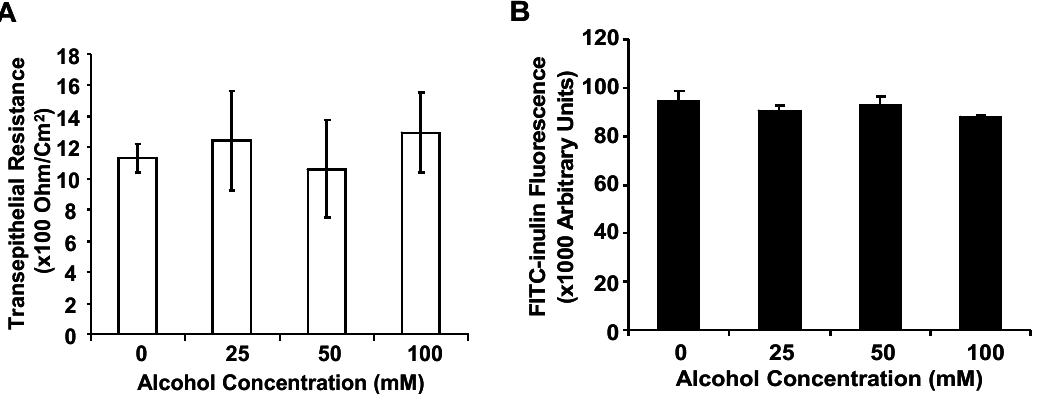
Figure 2. Effect of alcohol exposure on epithelial integrity and transepithelial permeability: NHBE cells were grown at the air-liquid interface and were exposed to different concentrations of alcohol for 24 h. ( A ) The effect of alcohol on epithelial cell monolayer integrity was investigated by measuring the transepithelial electrical resistance (TEER). As displayed, alcohol did not induce any significant changes in TEER; ( B ) The effect of alcohol on the transepithelial permeability was estimated by measuring the apical to basolateral diffusion of FITC-Inulin. The acute alcohol exposure did not markedly affect the transepithelial permeability. Data expressed is representative of two independent experiments carried out in quadruplicates.